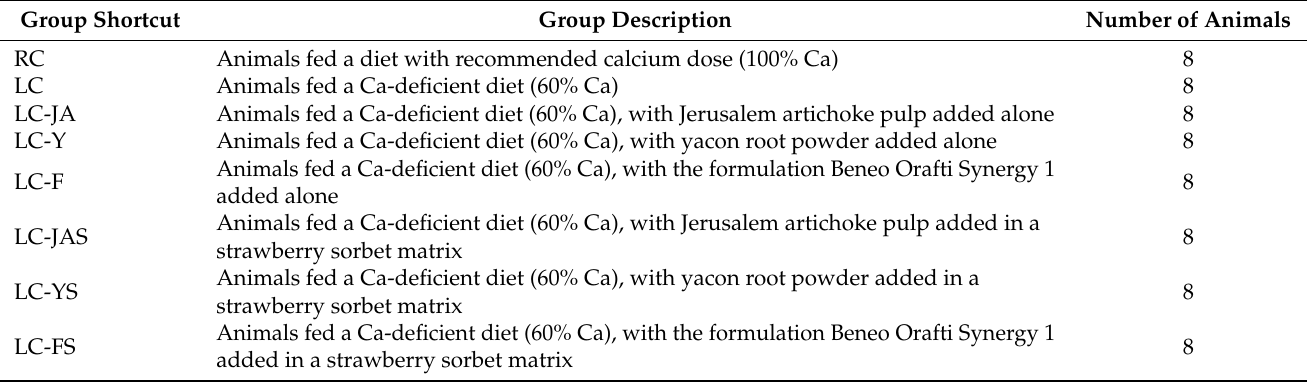
Table 1. Characteristics of experimental